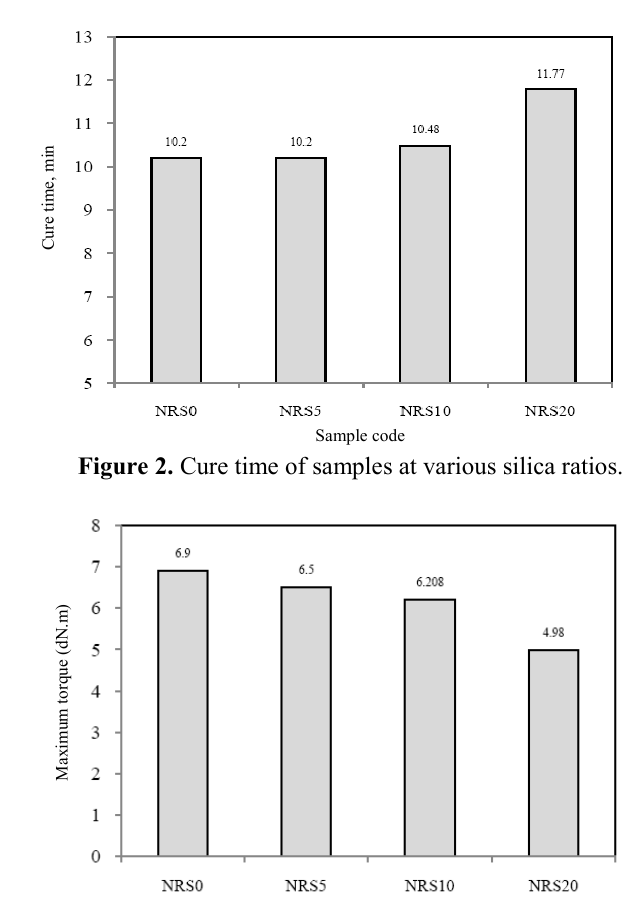
Figure 1. Scorch time of samples at various silica ratios.